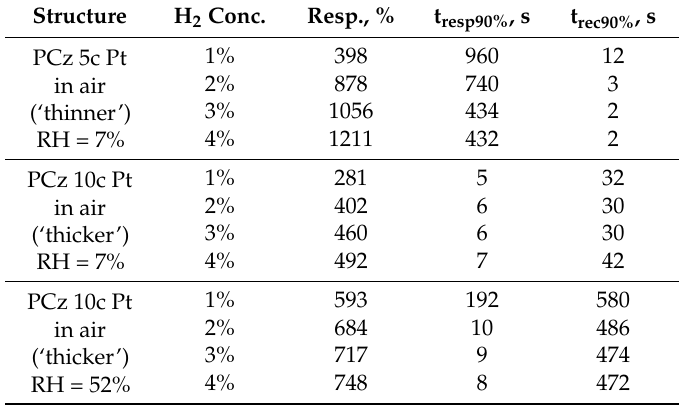
Table 1. Gas sensing properties of representative PCz/IDE-Pt sensors.